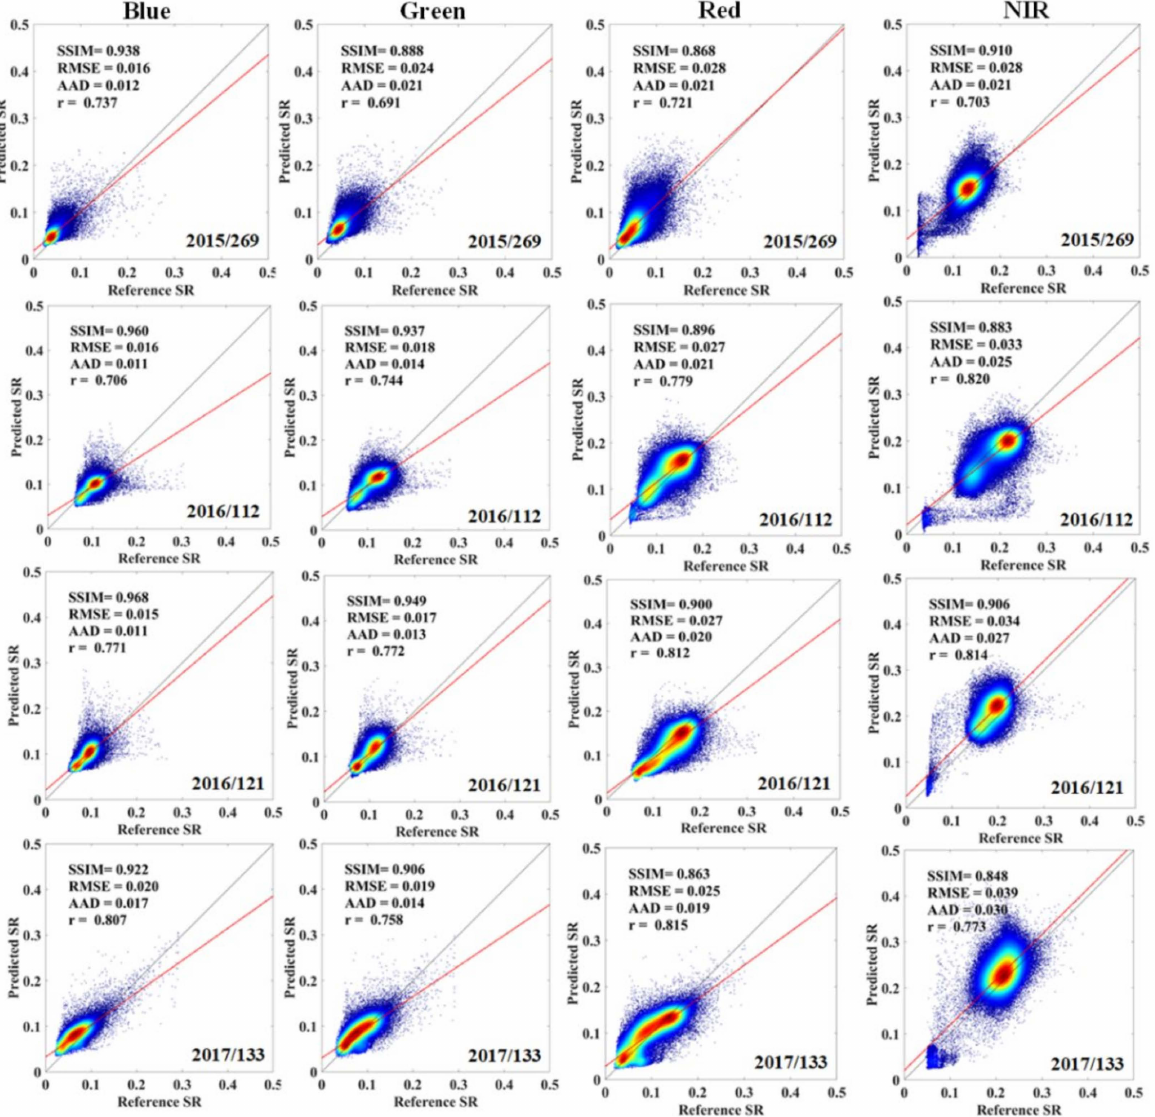
Figure 4. Scatter plots of predicted reflectance by the ERTFM and the actual GF-1 bands. The red line is the fitting line, and the black line is the 1:1